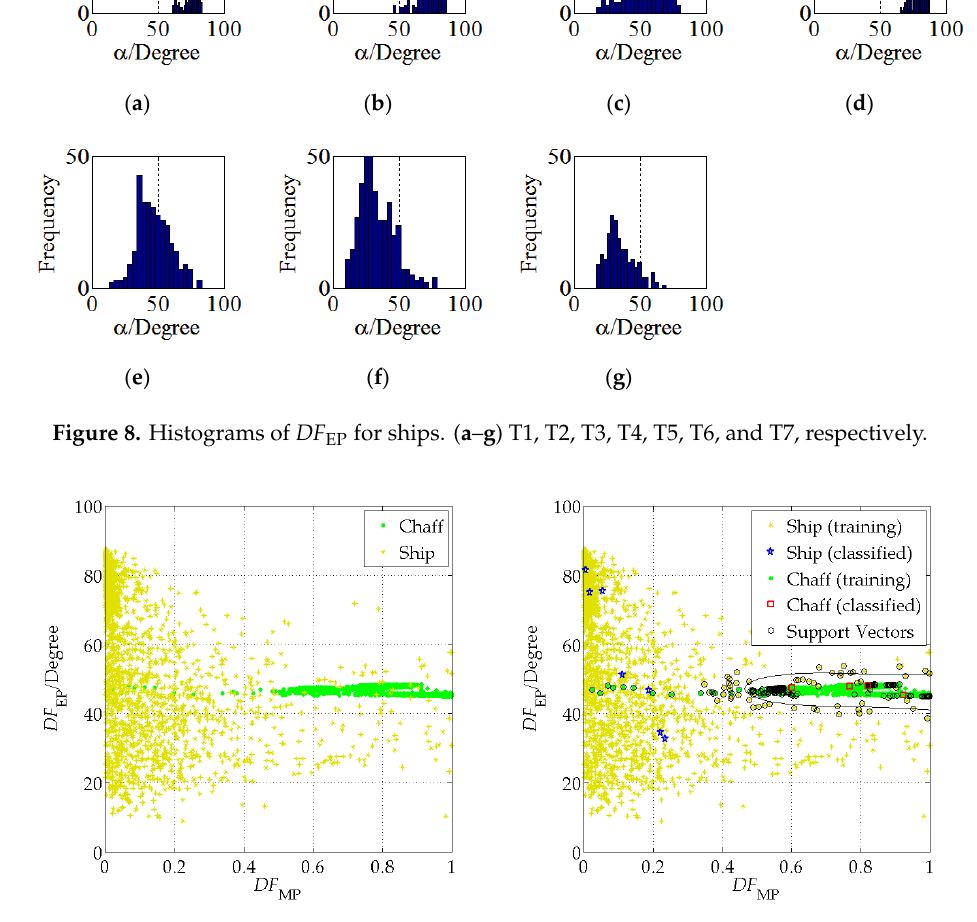
Figure 9. Recognition results of the proposed method. ( a ) Distribution of data points in the two dimensional DF − DF plane. ( b ) SVM-based classification results. Support vector machine-based classification results.